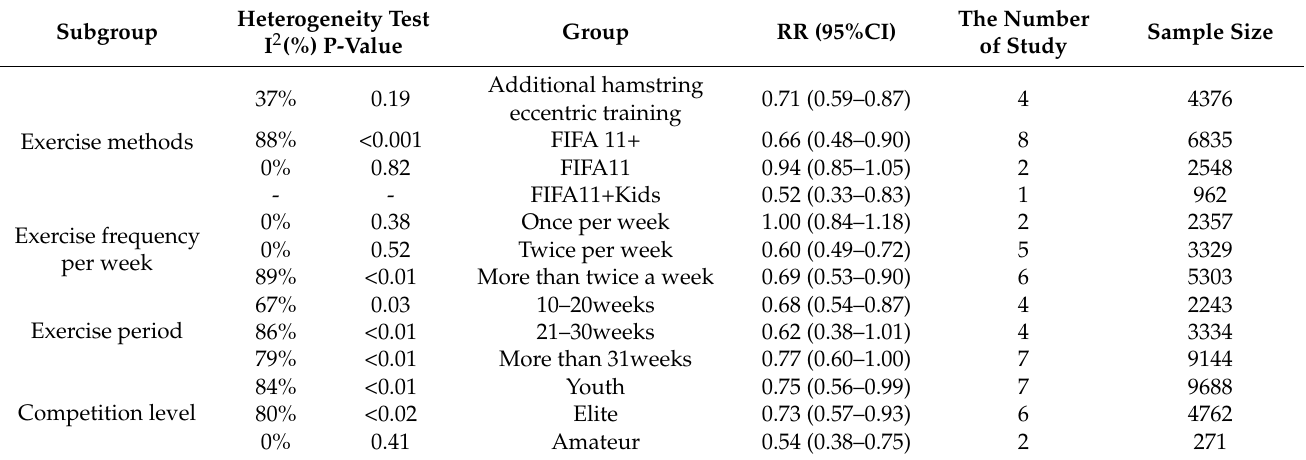
Table 1. Results of subgroup